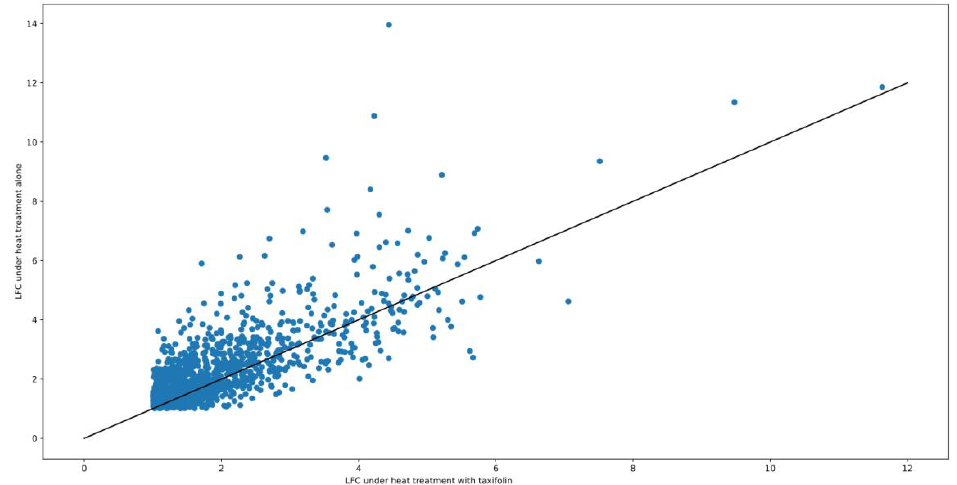
Figure 7. The scatter plot of LFC ratios in HSyes/HSno contrasts with or without taxifolin. Each point corresponds to a gene; the genes that are not DE in one of the contrasts are not included in this plot.